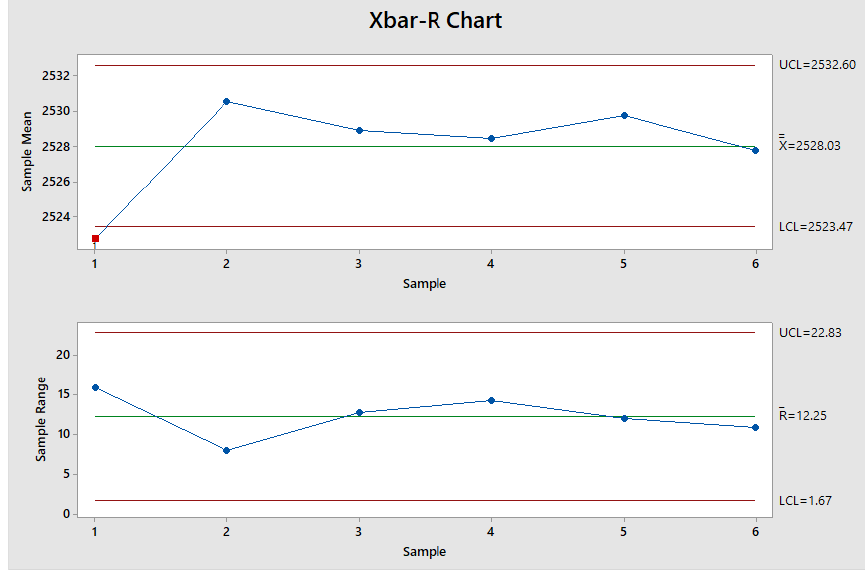
Figure 6. Control charts: Xbar-R chart.